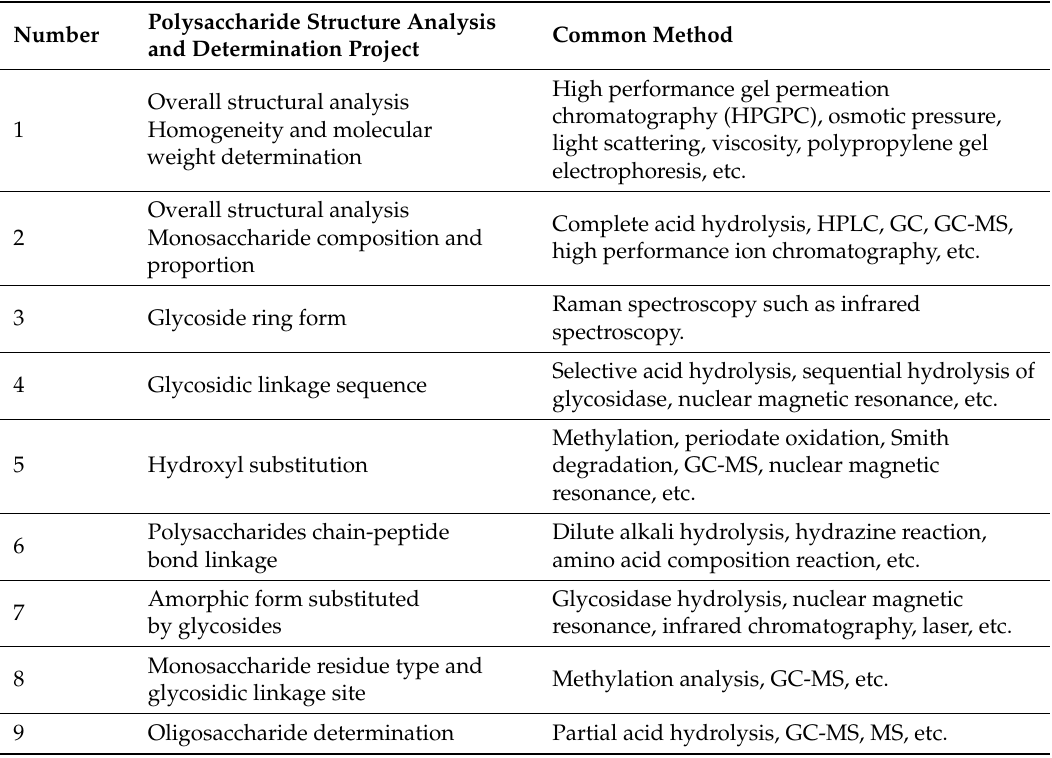
Figure 5. Analysis of the primary structure of polysaccharides (icon Table 5). Table 5. Common methods for determination of polysaccharide primary structure.